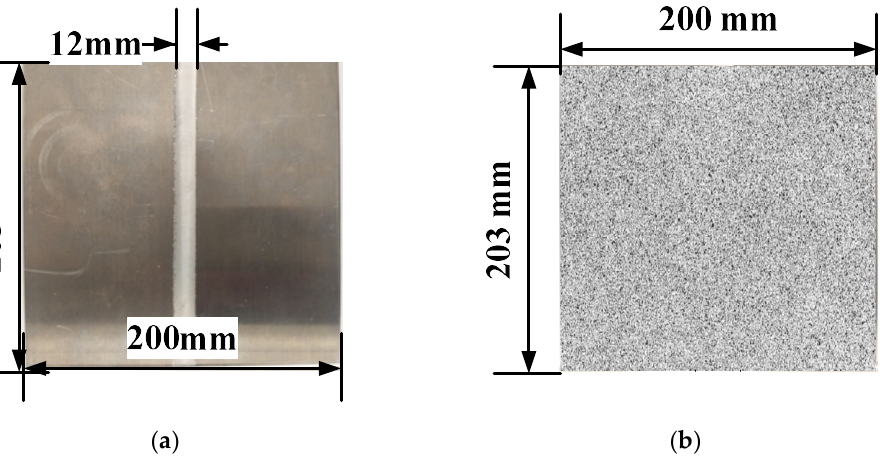
Figure 3. The morphology and size of AA5754 TWB ( a ) before spraying and ( b ) after spraying.